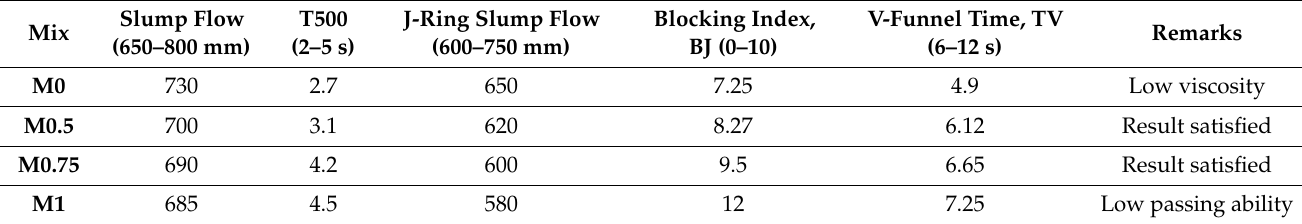
Table 6. Fresh properties’ results of all SCC mixes.